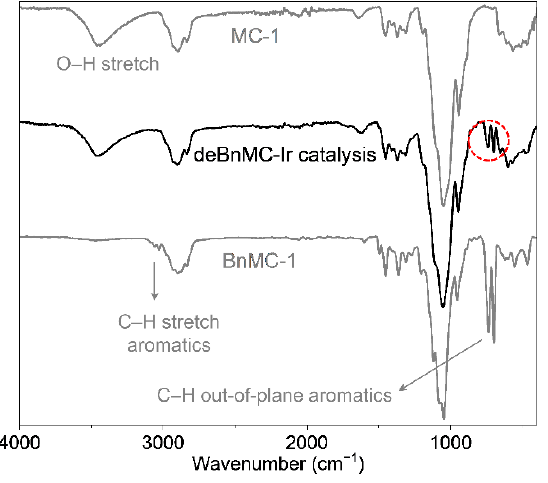
Figure 1. The ATR-IR spectrum of debenzylated BnMC-1 by homogeneous catalytic conversion in the presence of the Ir-catalyst (Scheme 1). Spectra of MC-1 and BnMC-1 are shown for comparison. The dashed-line circle shows peaks of the remaining aromatic groups.